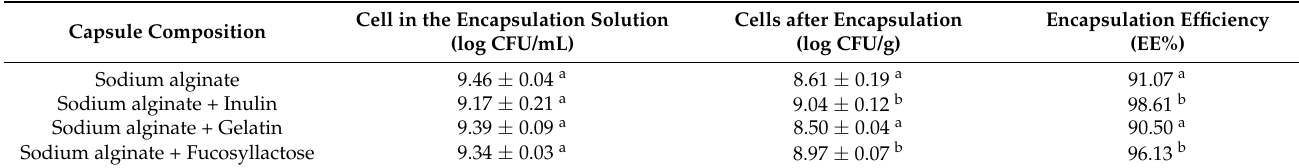
Table 1. Encapsulation efficiency (EE%) of S. thermophilus TH982 using different encapsulating matrices. Capsule